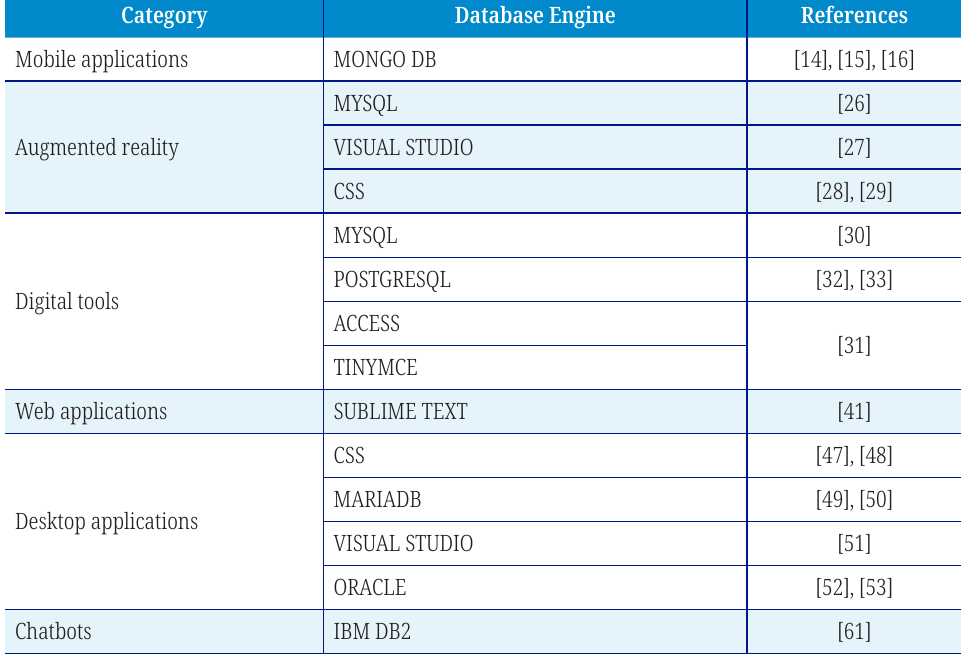
Table 5. Classification of articles according to category and database engine